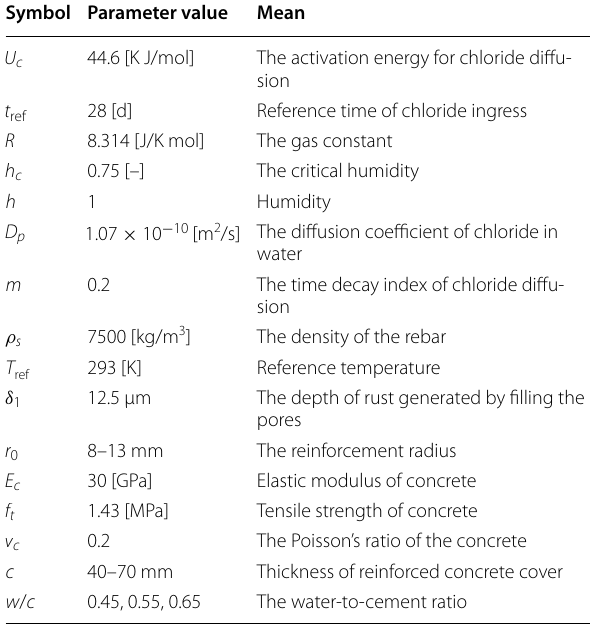
Table 1 Numerical simulation